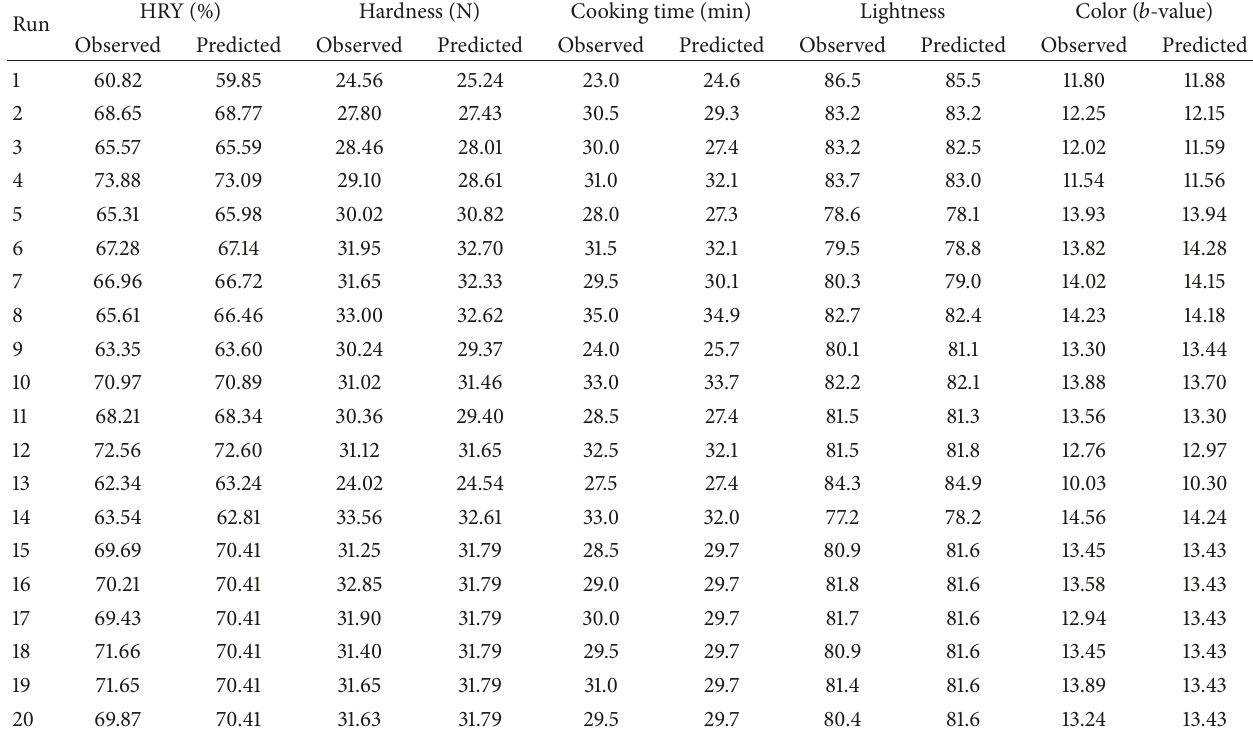
Table 2: Observed and predicted values for HRY, hardness, cooking time, lightness, and color of